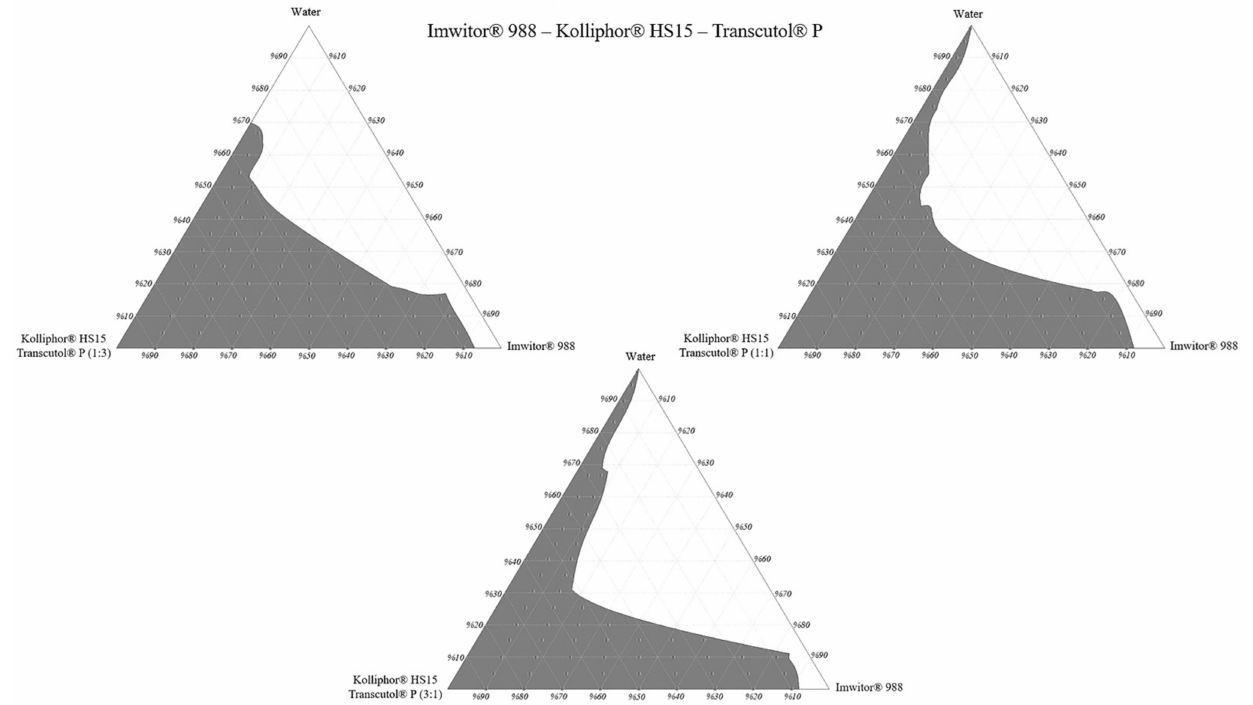
Figure 7. Pseudo ternary phase diagrams.